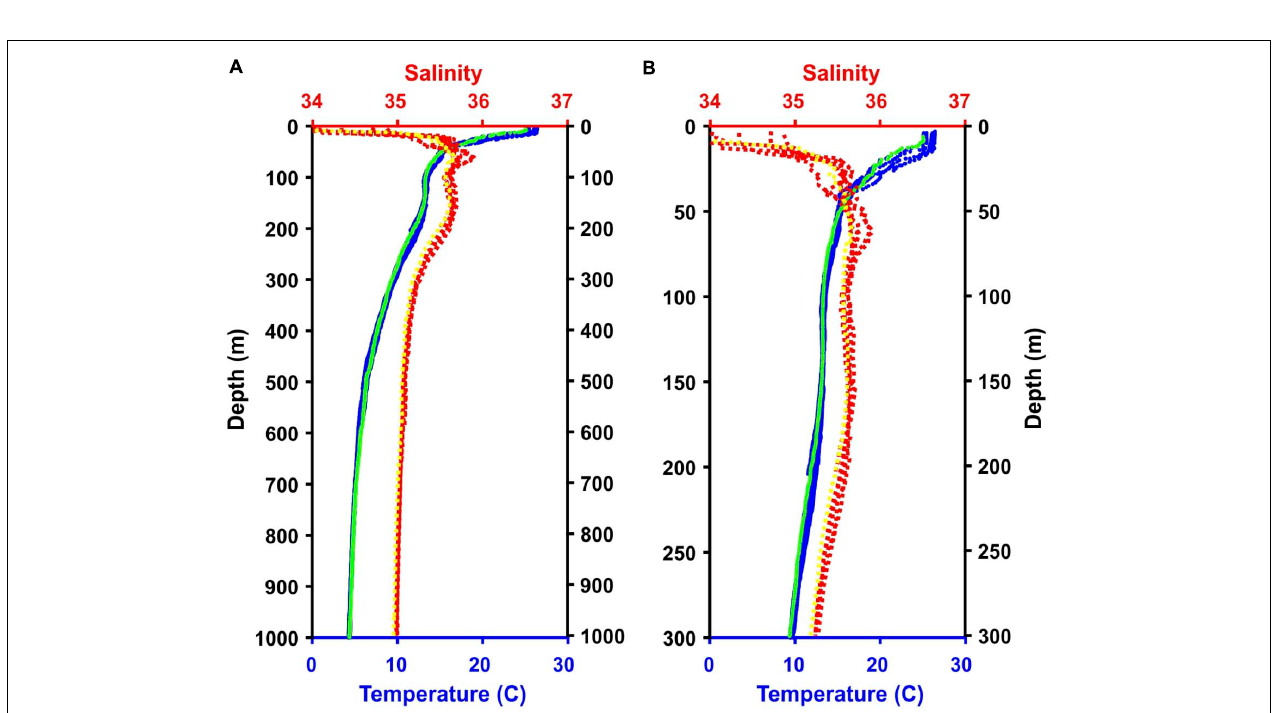
FIGURE 3 | Temperature and salinity data from the five CTD casts and the MOCNESS tow. Note, lines for all casts and the tow are present although they are not always visible because they overlap. (A) Data from 0 to 1,000 m. (B) Data from the top 300 m of the water column. Blue = CTD temperature data; Green = MOCNESS temperature data; Red = CTD salinity data; Yellow = MOCNESS salinity data.